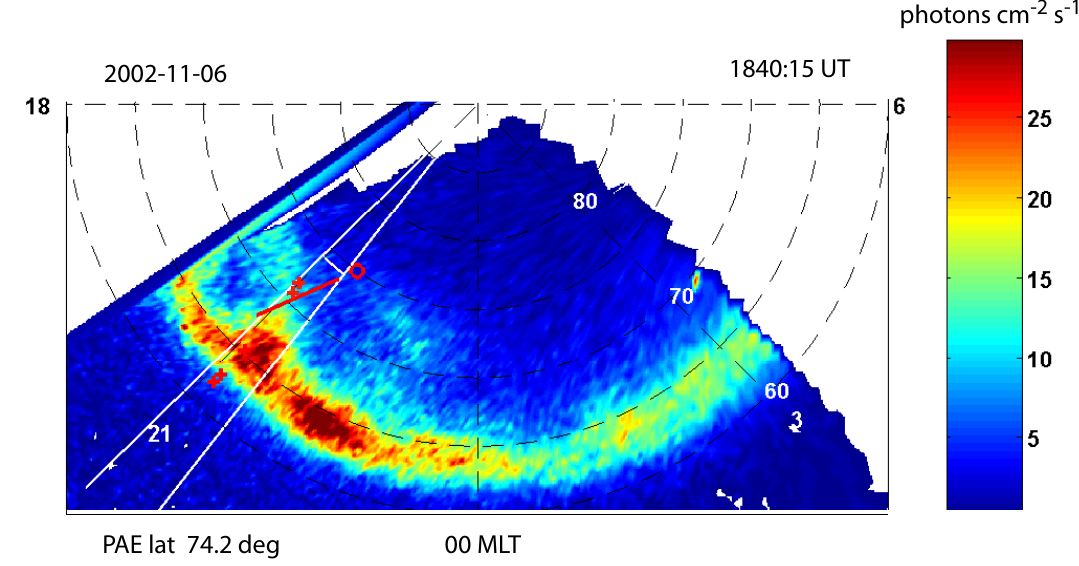
Fig. 6. Polar UVI taken at 18:40:15 UT in geomagnetic coordinates. The MLT zone used in calculating PAE is shown by white lines as well as the calculated PAE. The ESR 32m beam projection is shown in the figure. The crosses are the following DMSP boundaries: b 1 e , b 2 e , b 3 e and b 6.